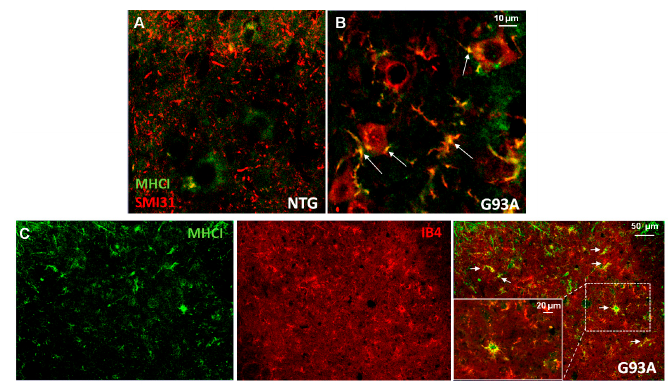
Figure 1. Major histocompatibility complex class I (MHCI) immunoreactivity in dystrophic neurites of motoneurons (MNs) and activated microglia. ( A , B ) Representative immunofluorescent